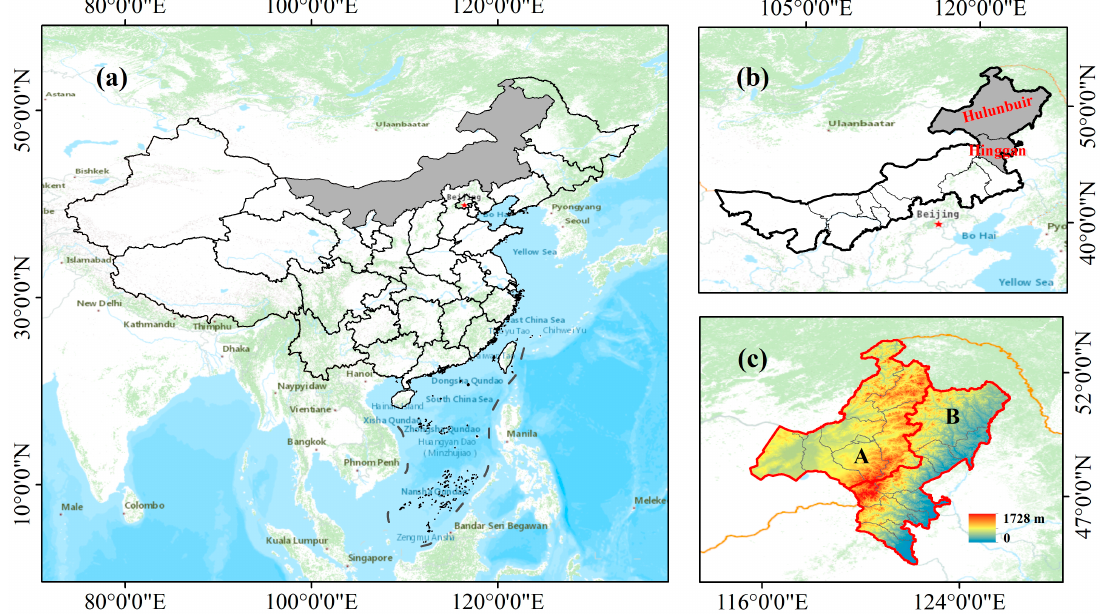
Figure 1. The location of ( a ) Inner Mongolia Autonomous Region (shaded area) of China, ( b ) the study area in Inner Mongolia with ( c ) two agro-ecological zones (AEZ A and AEZ B).